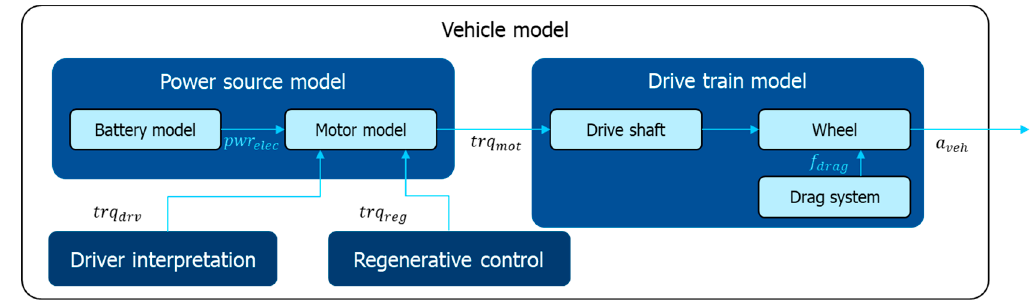
Figure 2. Vehicle model structure.